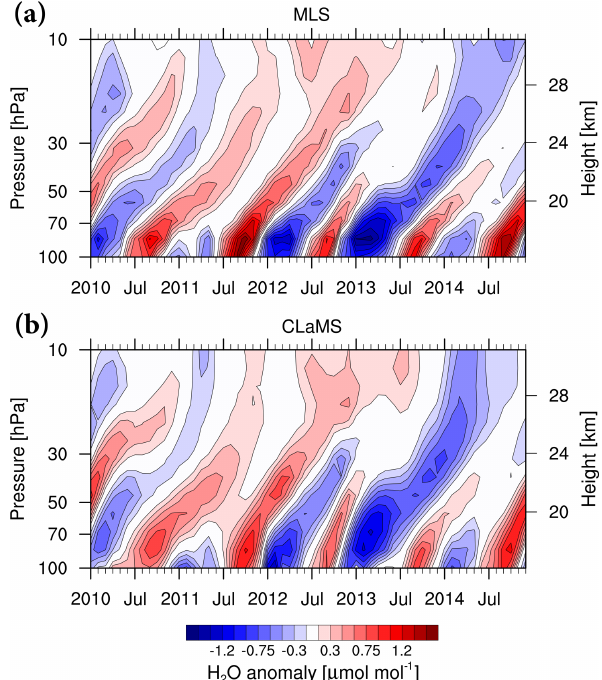
Figure 3. (a) H 2 O tape recorder signal from MLS data (in µmolmol − 1 , with steps of ± 0 . 15µmolmol − 1 starting at ± 0 . 15µmolmol − 1 ). The signal has been calculated as the zonally averaged temporal anomaly of H 2 O for the years 2010–2014 aver- aged over 10 ◦ S–10 ◦ N. Wet (dry) phases are shown in red (blue) and the strongest positive (negative) anomalies above (below) 1.5 ( − 1 . 5)µmolmol − 1 are coloured in dark red (blue). (b) As in (a) but for CLaMS data, which were processed for the comparison with MLS data (see Sect.